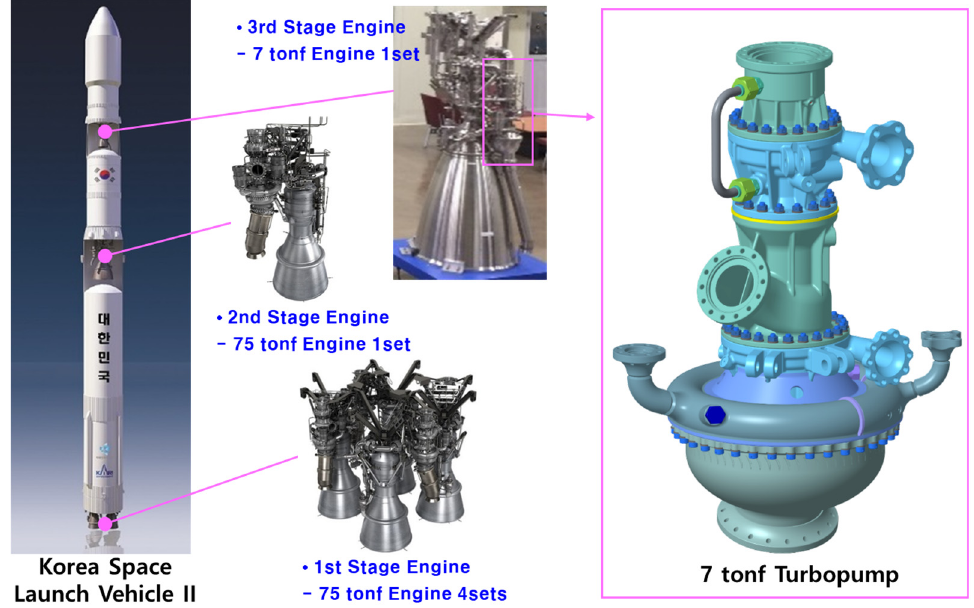
Figure 1. Korea Space Launch Vehicle II and 7 tonf turbopump.